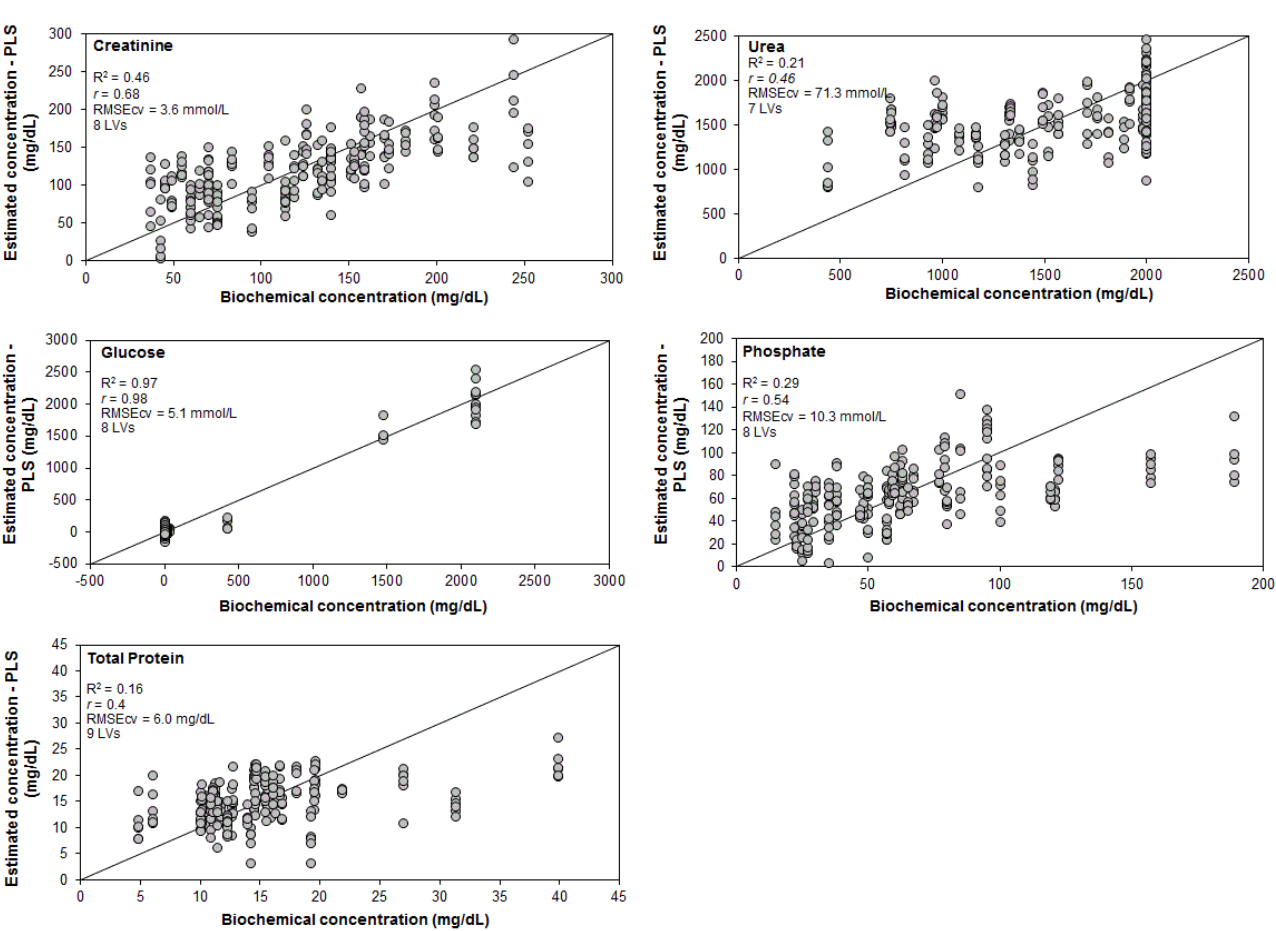
Figure 4. Correlation between the estimated concentrations of urea, creatinine, glucose, phosphate, and total protein in urine determined using spectral models based on PLS regression with leave-one-out cross-validation versus the concentrations determined by the spectrophotometry. Table 2. Confusion table with the results of the discriminant models used to classify subjects into CT and DM&HBP groups using LDA applied to the concentrations of the biomarkers obtained by spectrophotometric analysis and concentrations predicted by PLS regression. The classification by PLS-DA using the entire Raman spectra dataset is also presented.